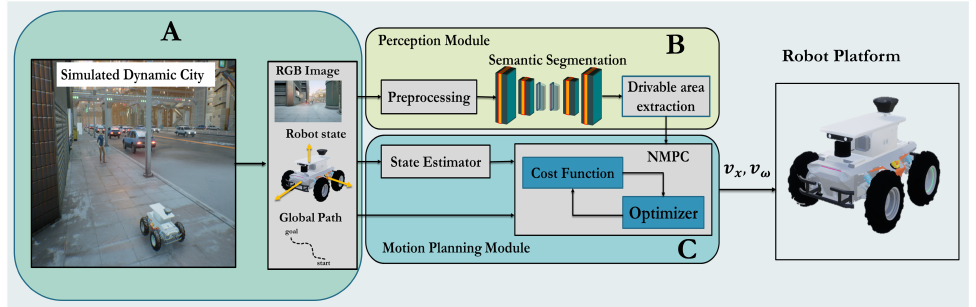
Figure 2. The overall block diagram of the proposed algorithms: ( A ) Unreal-Engine-based simulation of dynamic city with moving pedestrian. ( B ) The perception module based on semantic segmentation. ( C ) Local motion planner based on